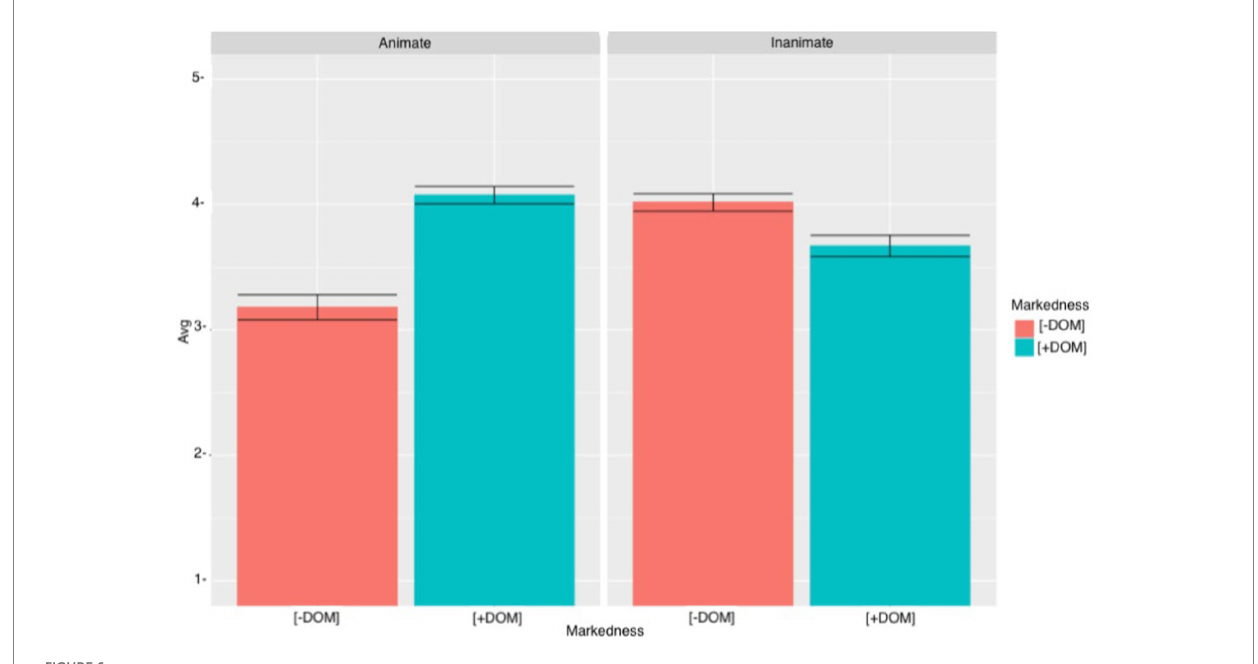
FIGURE 6 L2 learners’ mean acceptability scores and errors bars (95% CI) for SVO